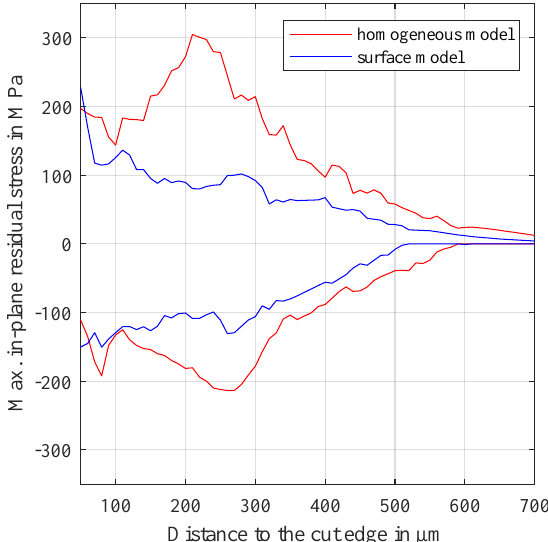
Figure 17. Residual tensile and compressive stress in the blanked electrical steel sheets according to the surface and homogeneous